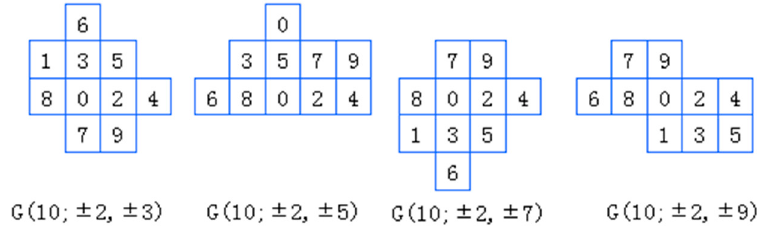
Figure 5. 𝐶 𝐺(10; ±2, ±𝑠) .